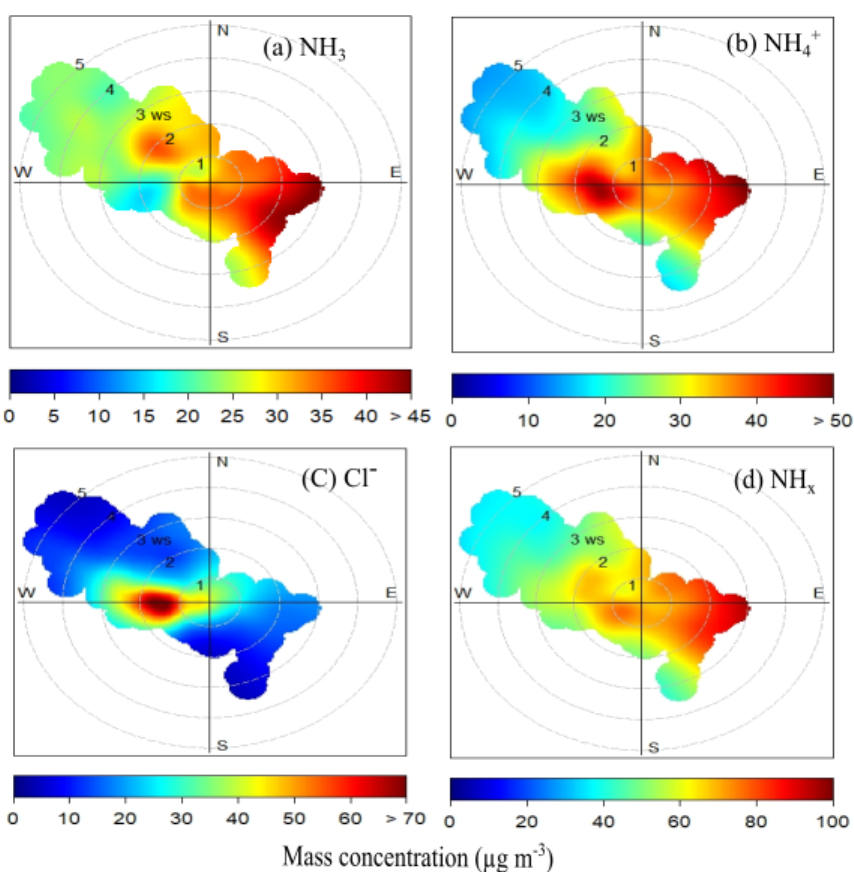
+ concentration, (c) Cl − concentration, and (d) total NH x concentration in 4